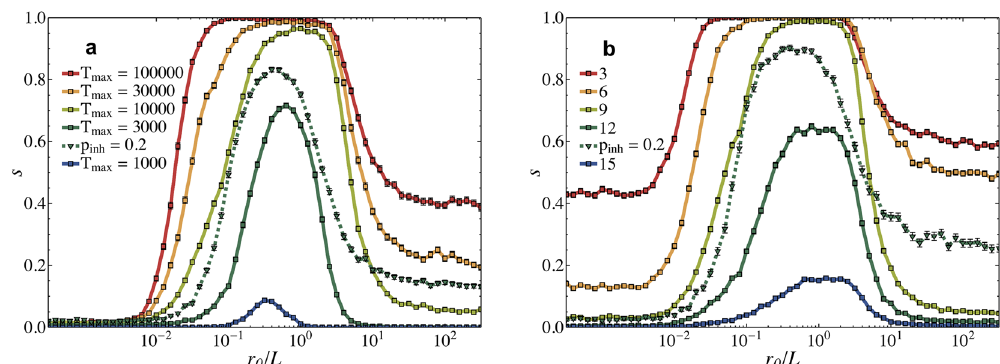
Figure 3. Ranges of the learning length optimizing the learning performance. The success rate s as a function of the learning length r 0 /L. ( a ) Different maximal learning times T max show a consistent improvement in performance ( N = 1000, d 0 = 2, t refr = 1, first ten patterns of Table 1). ( b ) The performance dependence on the number of patterns the system has to learn ( T max = 10000, N = 1000, t refr = 1, d 0 = 2). For T max = 3000 (in Fig. a ) and for 12 patterns (in Fig. b ) we also performed simulations with inhibitory neurons p inh = 0.2 resulting in an overall performance improvement. The error bar represent a 95% confidence